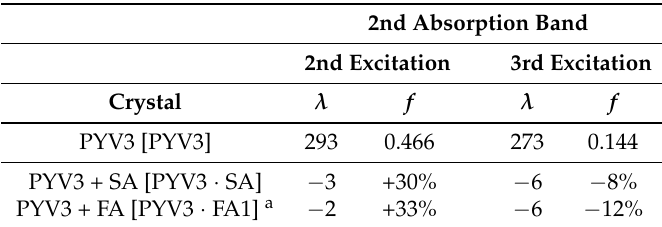
Table A6. RI-CC2/def2-TZVPD wavelengths of excitation, λ in nm, and oscillator strengths, f , for the enol forms of isolated PYV3 (PYV3 [PYV3]) and the heteromers of its co-crystals (PYV3 + XXX [PYV3 · XXX]). For PYV3 [PYV3], the absolute values are given while for the co-crystals, the absolute variations and relative variations are given for the wavelengths and oscillator strengths,